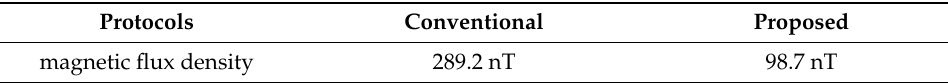
Figure 19. Deperming experiment results of SM45C depending on two deperming protocols: ( a ) conventional protocol and ( b ) proposed protocol. Table 2. Measured results for SM45C.